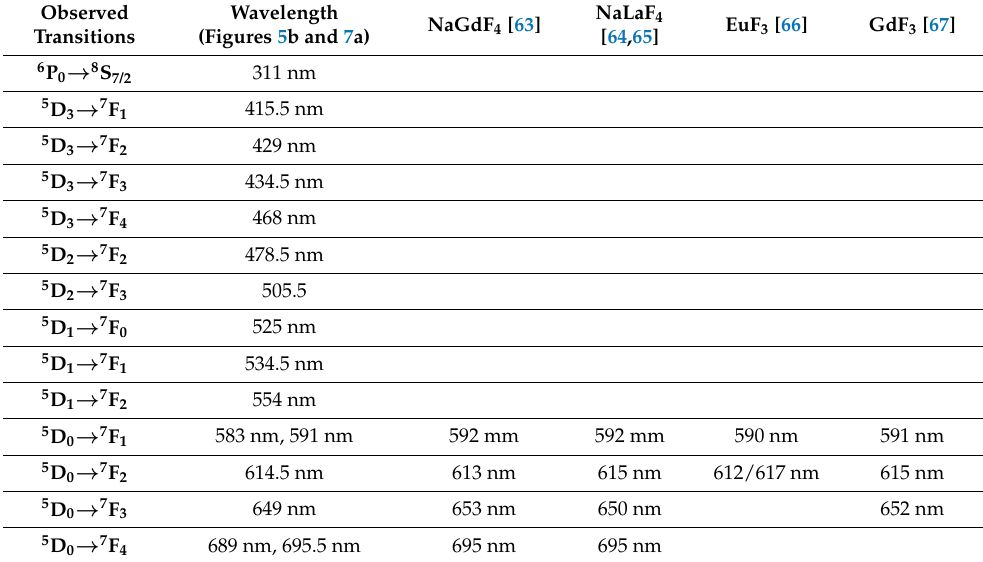
Table 1. Emission wavelengths corresponding to the observed transitions of Gd 3+ and Eu 3+ in NPs and